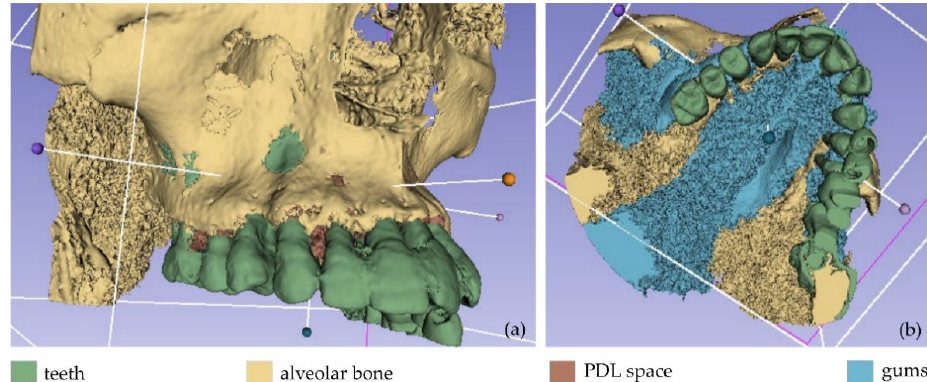
Figure 3. Non-processed 3D models as obtained by Experiment 1; ( a ): teeth, alveolar bone, and PDL space; ( b ) teeth, alveolar bone, PDL space, and gums.